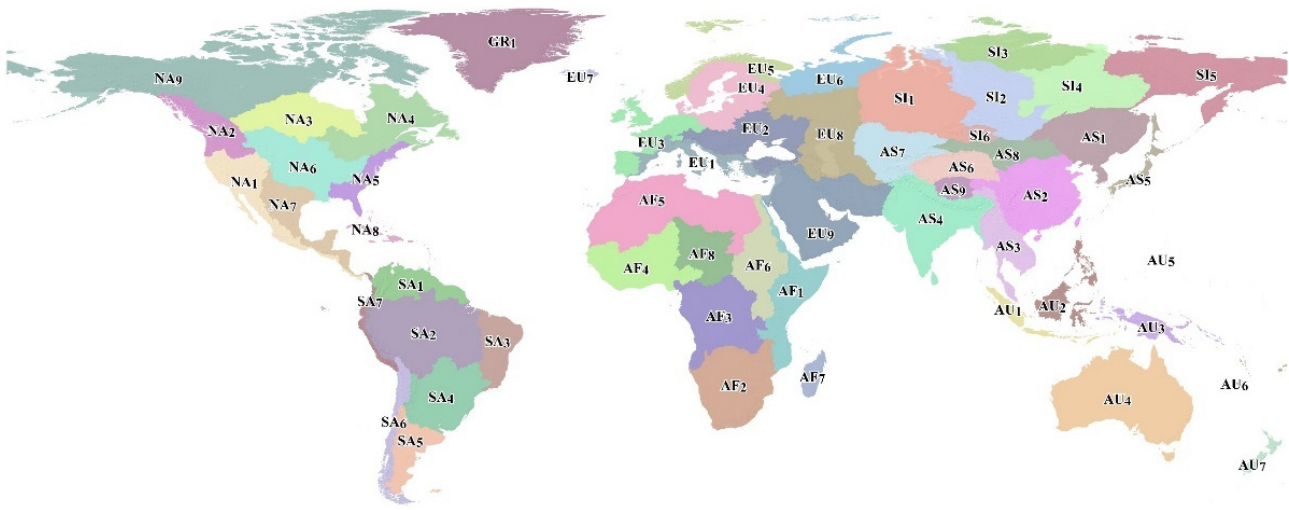
Figure 3. Global macro-areas adopted for WaterProof based on Hydrosheds level 2.